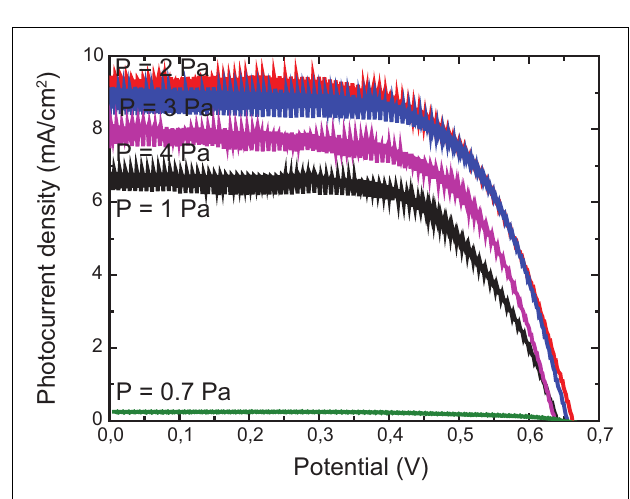
FIGURE 6 | Current-potential characteristics of theTiO 2 nanorods prepared at different sputtering pressures